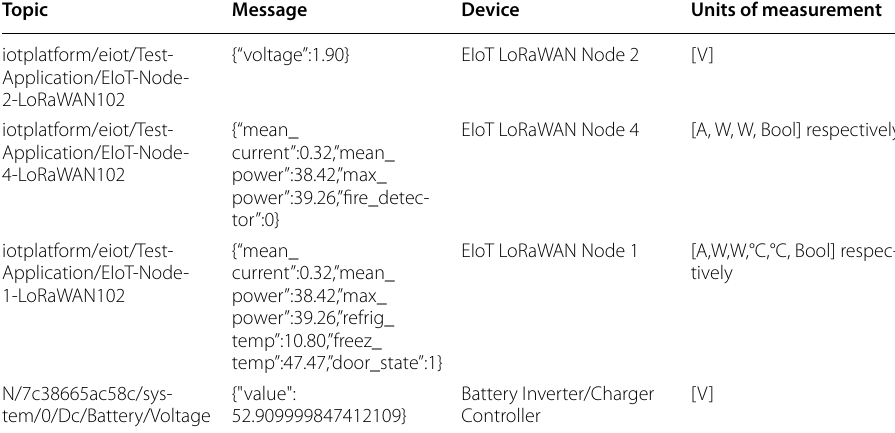
Table 2 MQTT messages by subscription topics Topic Message Device Units of